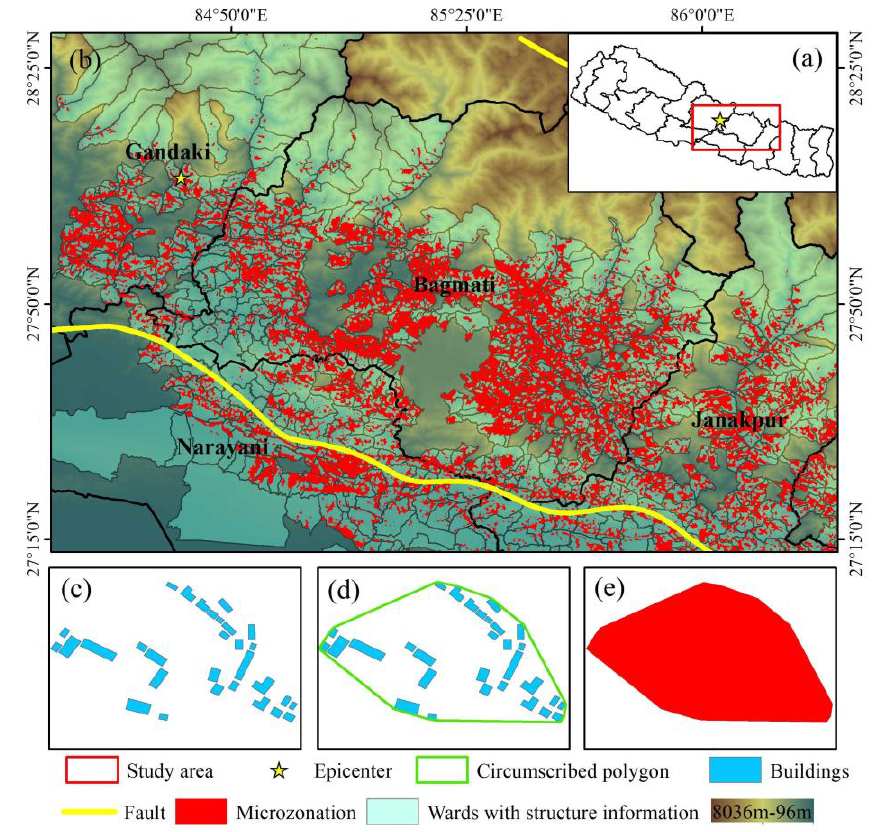
Figure 2. Distribution of building regions with structural information and refined building regions. Subplot ( a ) shows the geographical location of all microzones. Subplot ( b ) shows the distribution of all microzones. The background is terrain, and the light green regions are the administrative wards with building structure information. The longer yellow line in subplot b represents the seismogenic fault. Subplots ( c – e ) show the refinement process of the building regions, transforming the building regions from wards to microzones. The Green wireframe is the circumscribed polygon of blue buildings in subplot ( d ); the red parts are building regions after refinement named microzones, and the red polygon in subplot ( e ) is one of the microzones.